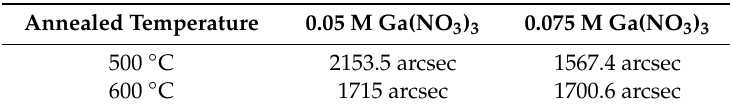
Figure 4. XRD patterns of Ga 2 O 3 obtained from thermal-treated GaOOH samples for 3 h at various temperatures ( a ) 400 °C, ( b ) 500 °C and ( c ) 600 °C. Table 1. The FWHM data of (104) α -Ga 2 O 3 diffraction peaks obtained from post-annealed GaOOH samples with 0.05 and 0.075 M Ga(NO 3 ) 3 concentrations.